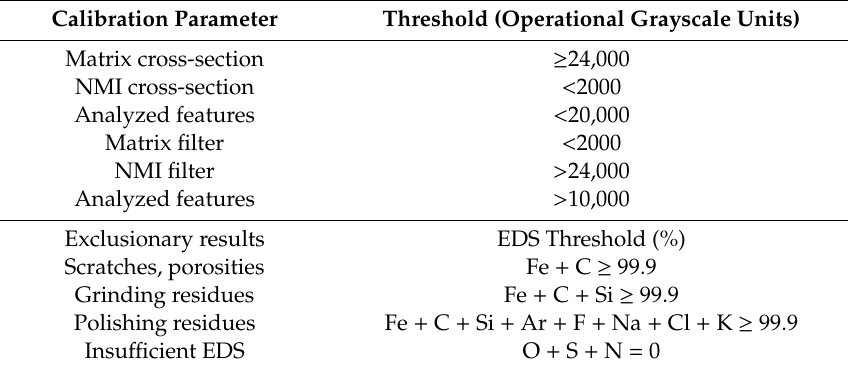
Table 2. Greyscale parameters and EDS data processing